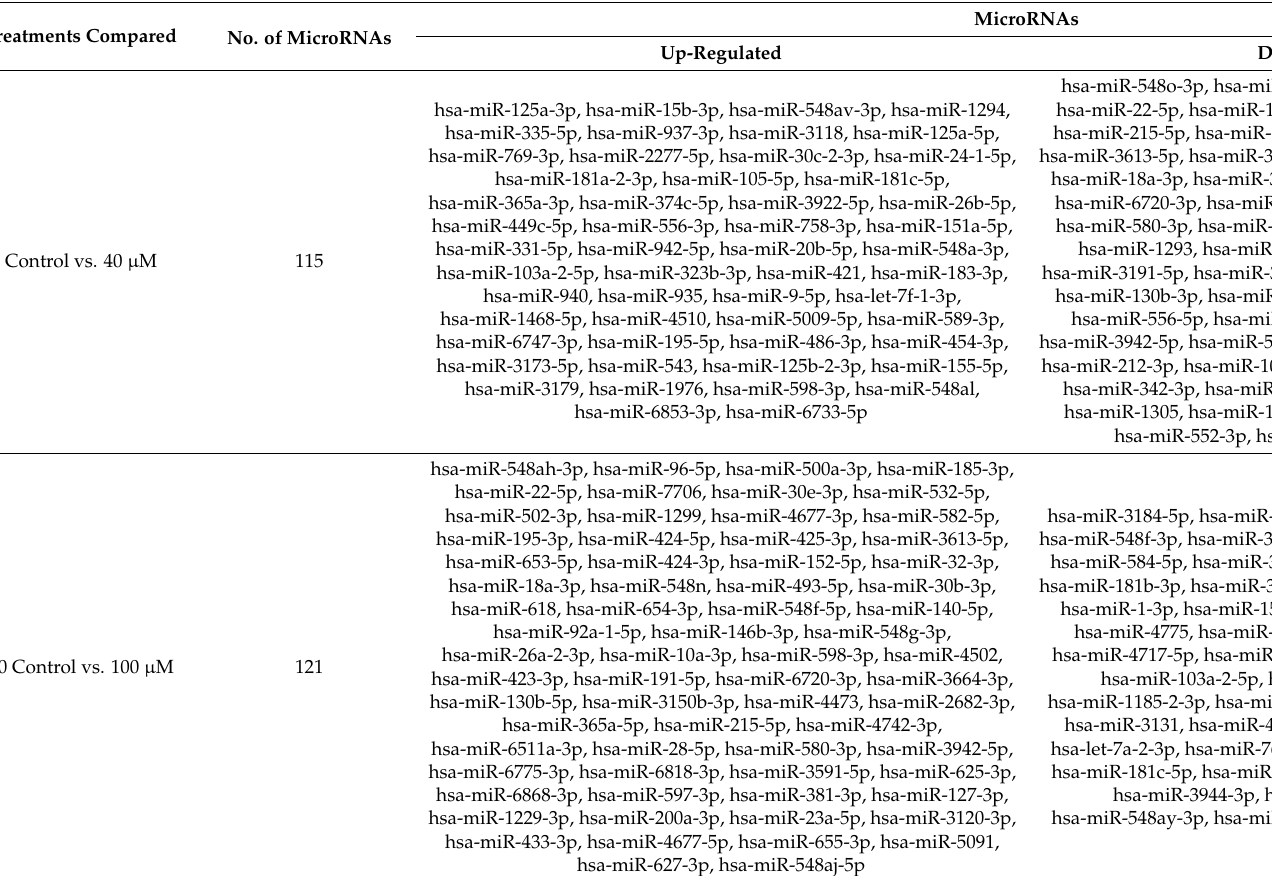
Table 2. List of known microRNAs with greater than 2 log2 fold change expression after 40 and 100 µ M EGCG